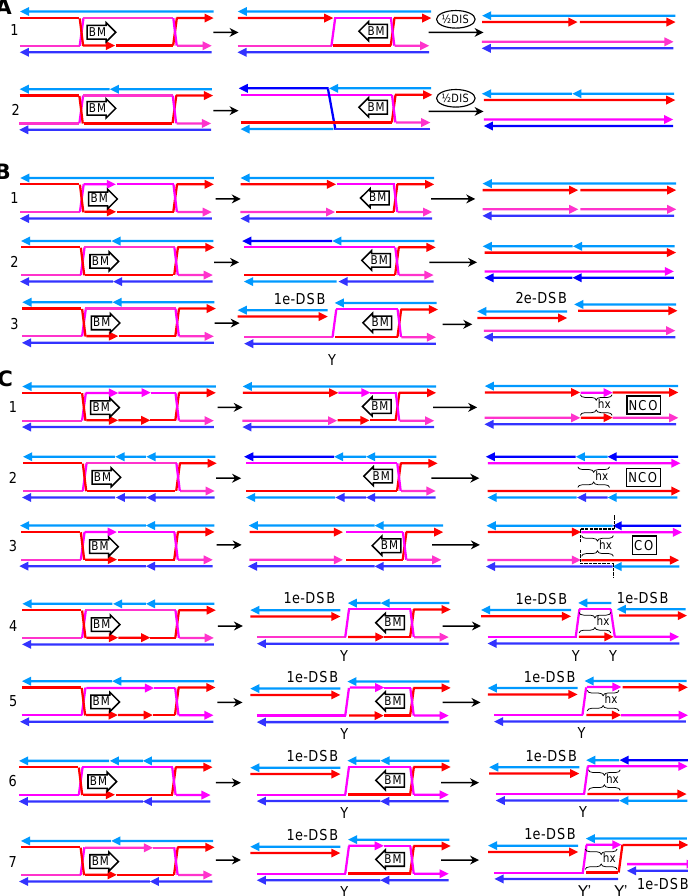
Figure 9. Inferences of metastable nicks during branch migration of a DPE dcHJ. ( A ) Scenarios with one nick: (1) in a crossover strand; (2) in a non-crossover strand. ( B ) Scenarios with two opposing nicks: (1) in the crossover strands; (2) in the non-crossover strands; (3) in one crossover and one non-crossover strand. ( C ) Scenarios with two partners of opposing nicks: (1) all four nicks in the crossover strands; (2) all four nicks in the non-crossover strands; (3) one partner in the crossover strands and the other one in the non-crossover strands; (4) both partners in a crossover/non-crossover arrangement, with only two affected strands; (5) one partner in a crossover/non-crossover arrangement, and the other one in the crossover strands; (6) one partner in a crossover/non-crossover arrangement, and the other one in the non-crossover strands; (7) both partners in a crossover/non-crossover arrangement, with all four strands holding a nick. 1e-DSB, one-ended DSB; 2e-DSB, two-ended DSB; Y and Y’, RF-like structures. Y-Y partner resembles a replication bubble, whereas the Y’-Y’ partner makes a bubble-like JM that connects a CO-to-be chimera. See previous figure legends for other abbreviations and